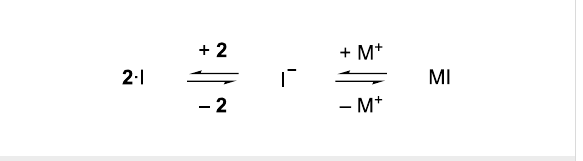
ence of NaF, KF, and CsF being 1.6, 1.9, and 1.8 nm.